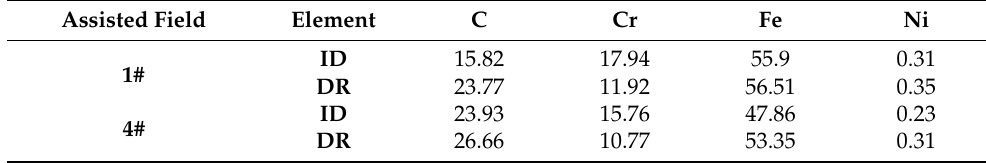
Table 3. EDS analysis results of coatings (at. %).